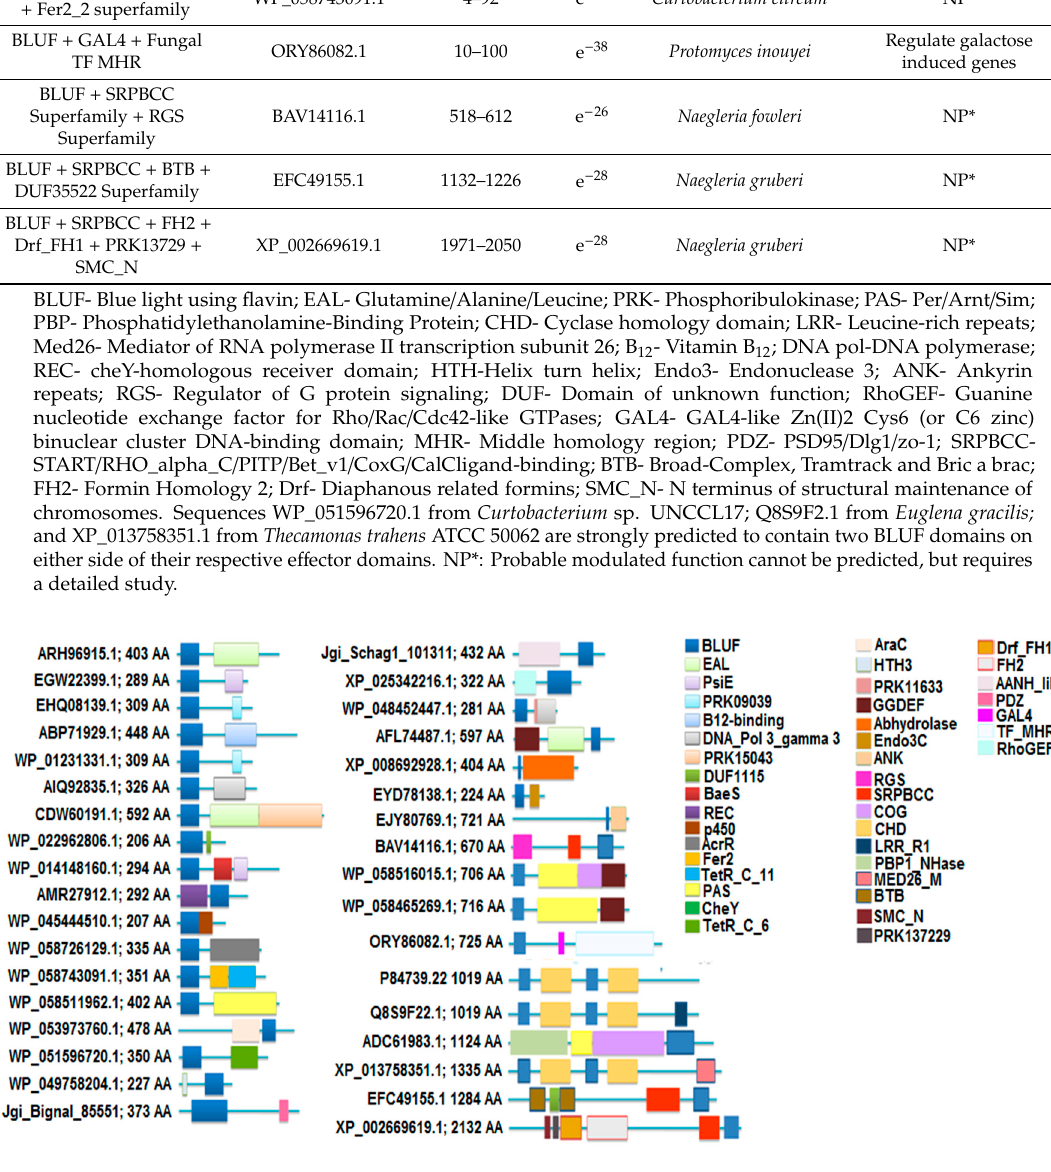
Figure 1. Schematic representation of the different blue light using flavin (BLUF) modular domain containing proteins. The accession numbers were taken from National Center for Biotechnology Information (NCBI). The mentioned “AA” indicates the amino acid numbers of the particular BLUF modular protein.